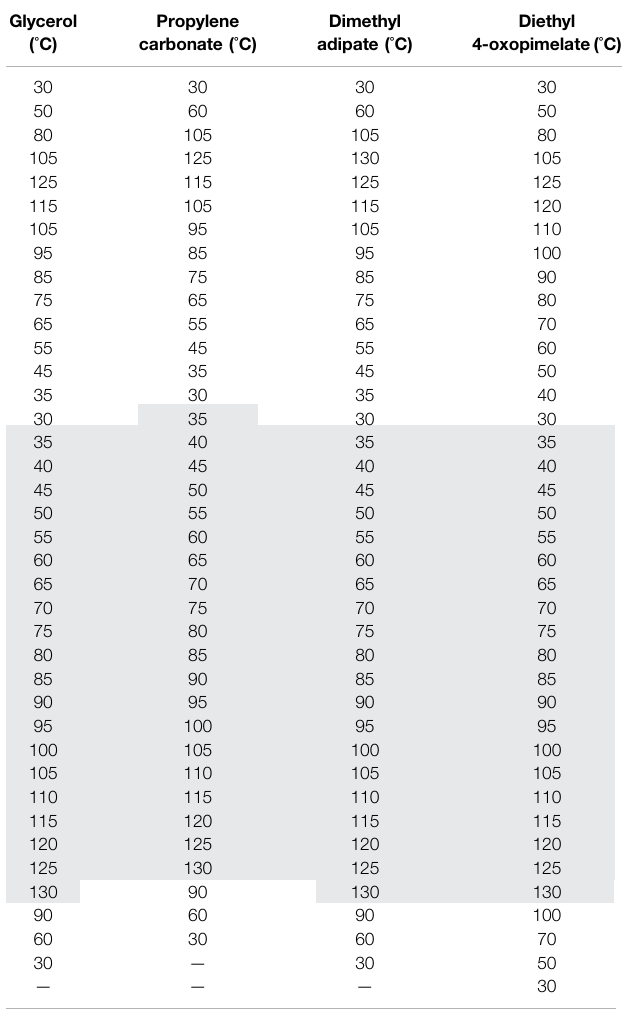
TABLE 2 | Full temperature cycle for dielectric relaxation spectroscopy experiments conducted on the solvated membranes in this study. The dark gray shaded region indicates the heating cycle where the conductivity data was taken from. Glycerol ( °